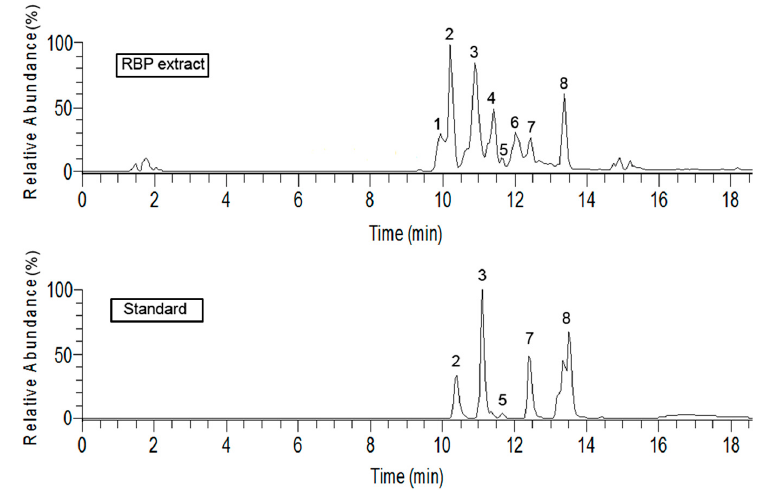
Figure 1. Total ion chromatograms of RBP extract and standard substances. Note: standard 2 = rutin, standard 3 = quercitrin, standard 5 = quercetin, standard 7 = kaempferol, and standard 8 = isorhamnetin.